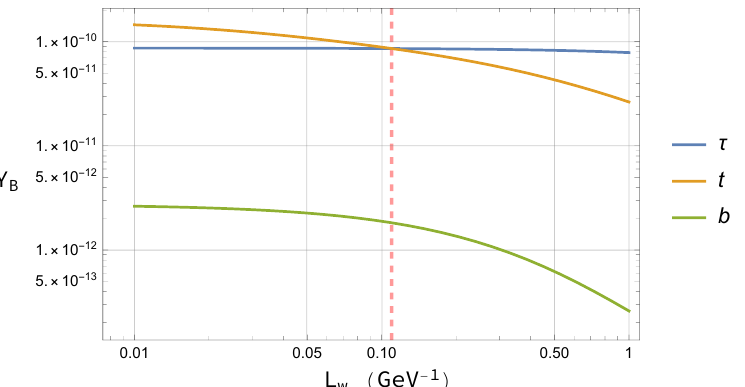
Figure 8. The baryon asymmetry Y B as a function of the bubble wall width L w . Each curve represents a source term. The benchmark value L w = 0 . 11 GeV − 1 is marked in dashed-red. The choice of T τ,t,b is the same as in figure I